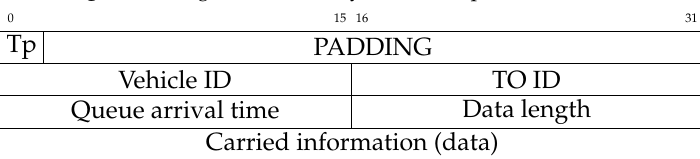
Figure 4. Neighbor Discovery Broadcast packet structure.